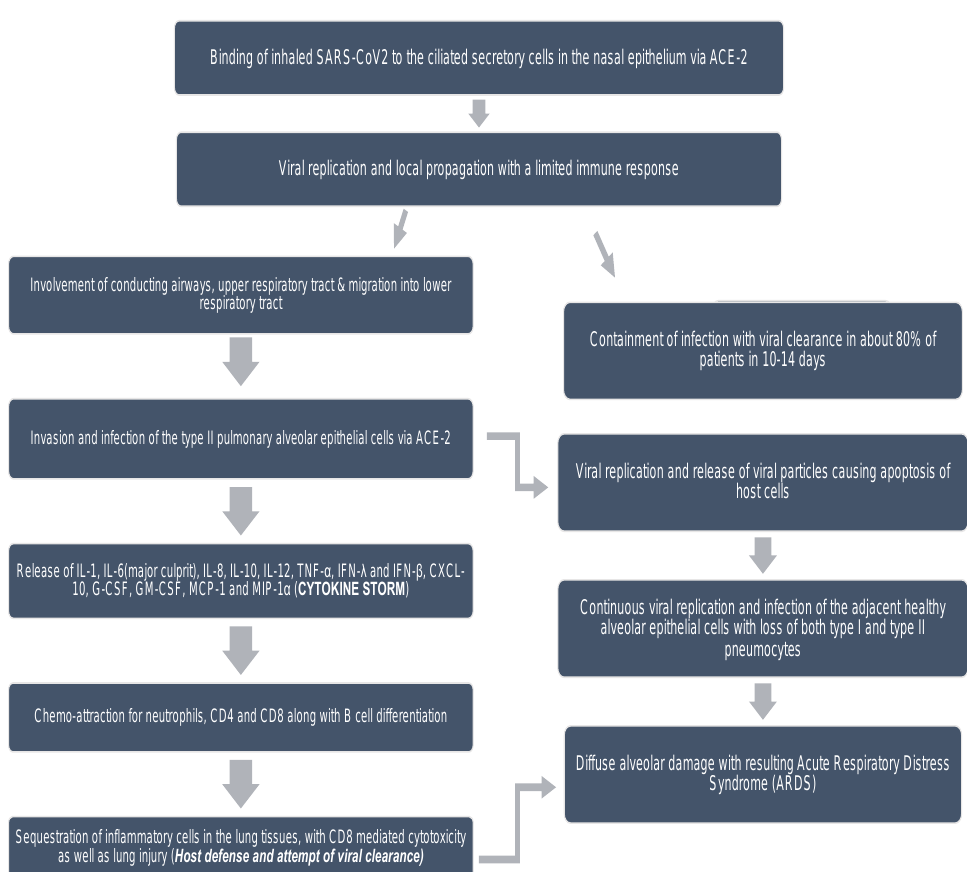
Figure 2. COVID-19 pathophysiology demonstrating disease progression from virus entrance in the body to causing acute respiratory distress syndrome (ARDS) [21].